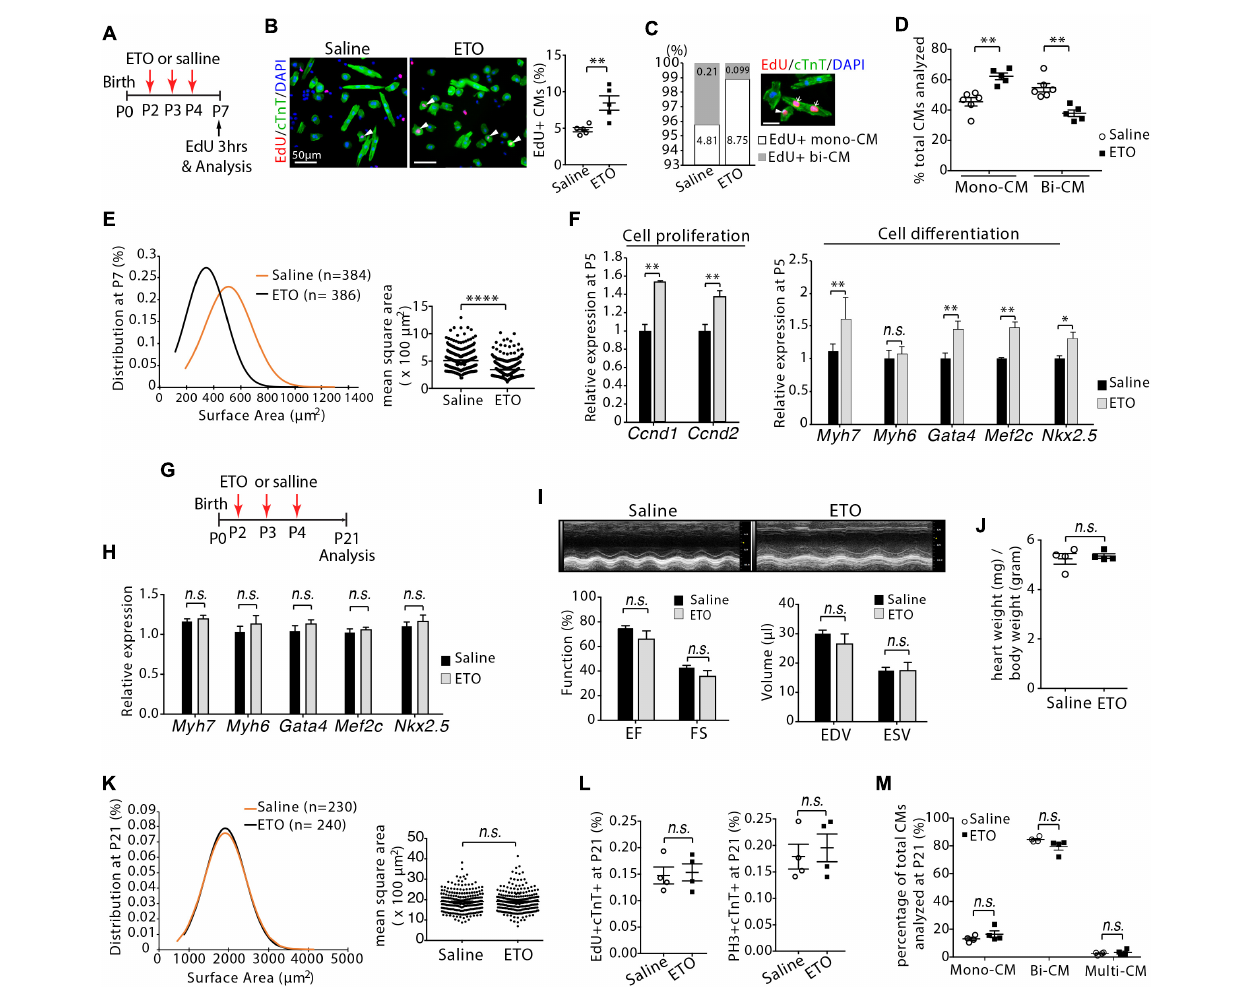
FIGURE 4 | Cardiomyocyte size growth and maturation with etomoxir (ETO) treatment. (A) Schematic of experimental design for experiments performed in panels (B–E) . (B) Isolated cardiomyocytes in DNA synthesis-phase were visualized by immunofluorescent microscopy using Click-iT EdU Alexa Fluor (red) and co-immunostaining with antibody against cTnT (green). Arrowheads point to EdU+cTnT+ cells. Quantification of EdU+cTnT+ cells as percentage of total cTnT+ cells ( ∼ 940 cTnT+ cells per sample). Scale bars: 50 µ m. (C) The percentage of mononucleated EdU+ cardiomyocytes (Mono-CM) and binucleated EdU+ cardiomyocytes (Bi-CM) at P7. Arrowheads point to mononuclear EdU+cTnT+ cells. Arrows point to binuclear EdU+cTnT+ cells. Scale bar: 25 µ m. (D) Percentage of mononuclear (Mono-CM) and binuclear (Bi-CM) cardiomyocytes in the heart ventricles of infant mice at P7. (E) The frequency distribution and mean square areas of the surface area of cardiomyocytes isolated from P7 mouse heart ventricles. (F) Expression of indicated genes by qRT-PCR analysis of the mRNA of isolated heart ventricles at P5 ( n = 5 per group). (G) Schematic of experimental design for experiments performed in panels (H–M) . (H) Quantification of gene expression by qRT-PCR analysis of the mRNA of isolated heart ventricles at P21 ( n = 4 per group). (I) Cardiac function in mice evaluated by echocardiography at P21 ( n = 4 per group). EF, ejection fraction; FS, fractional shortening; EDV, end-diastolic volume; ESV, end-systolic volume. (J) Heart weight-to-body weight ratios at P21. (K) The frequency distribution and mean square areas of isolated ventricular cardiomyocytes at P21. (L) Quantification of EdU+cTnT+ and PH3+cTnT+ as percentage of total cTnT+ cells analyzed on heart sections at P21. (M) Percentage of mononuclear (Mono-CM), binuclear (Bi-CM) and multinuclear (Multi-CM) cardiomyocytes in the heart ventricles of adult mice at P21. P value was calculated using Student’s t